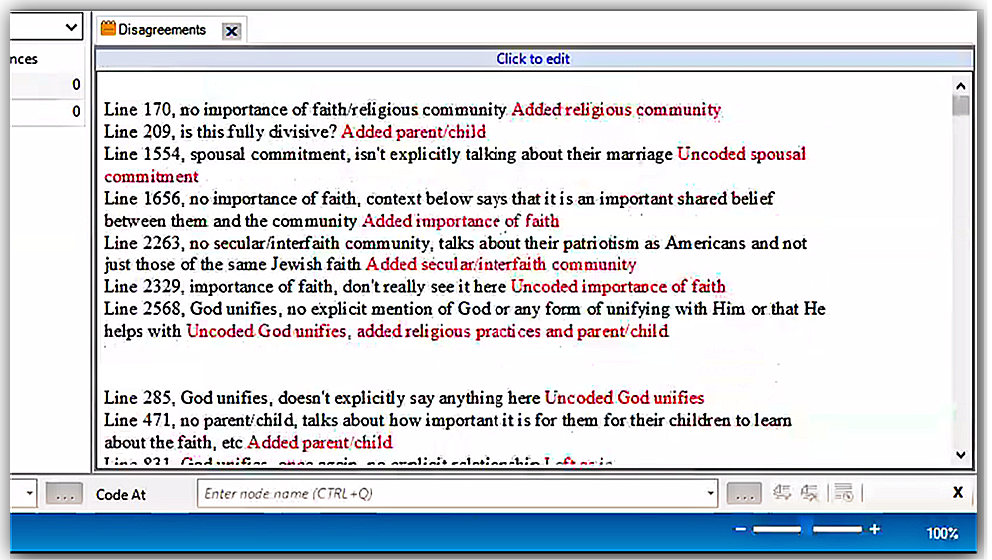
Figure 4. Example of a partner review memo with red text indicating where partner’s had unresolv- able